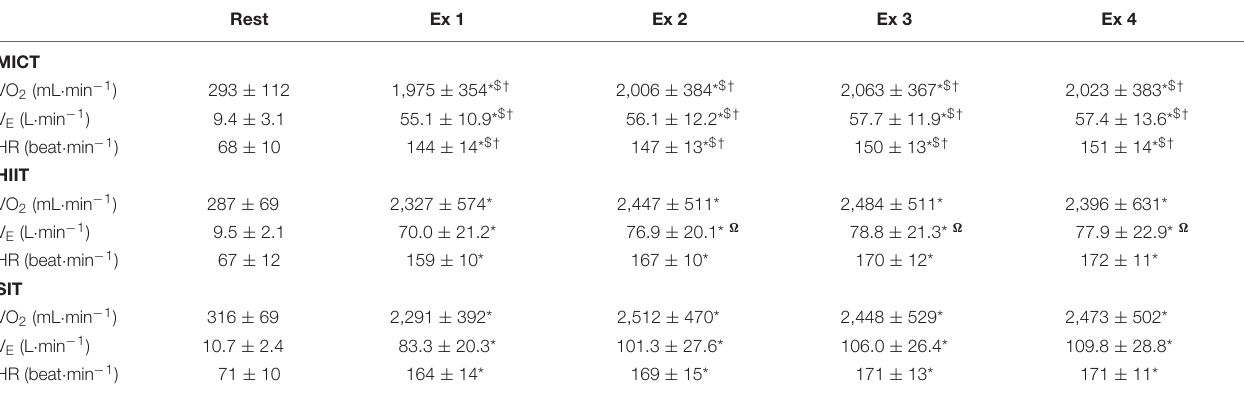
TABLE 2 | Measures of oxygen consumption, minute ventilation, and heart rate at rest and across the duration of three different exercise protocols. Rest Ex 1 Ex 2 Ex 3 Ex 4